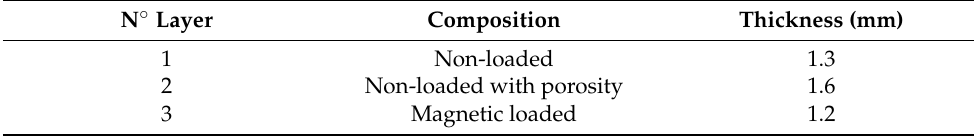
Table 3. Composition of the optimized